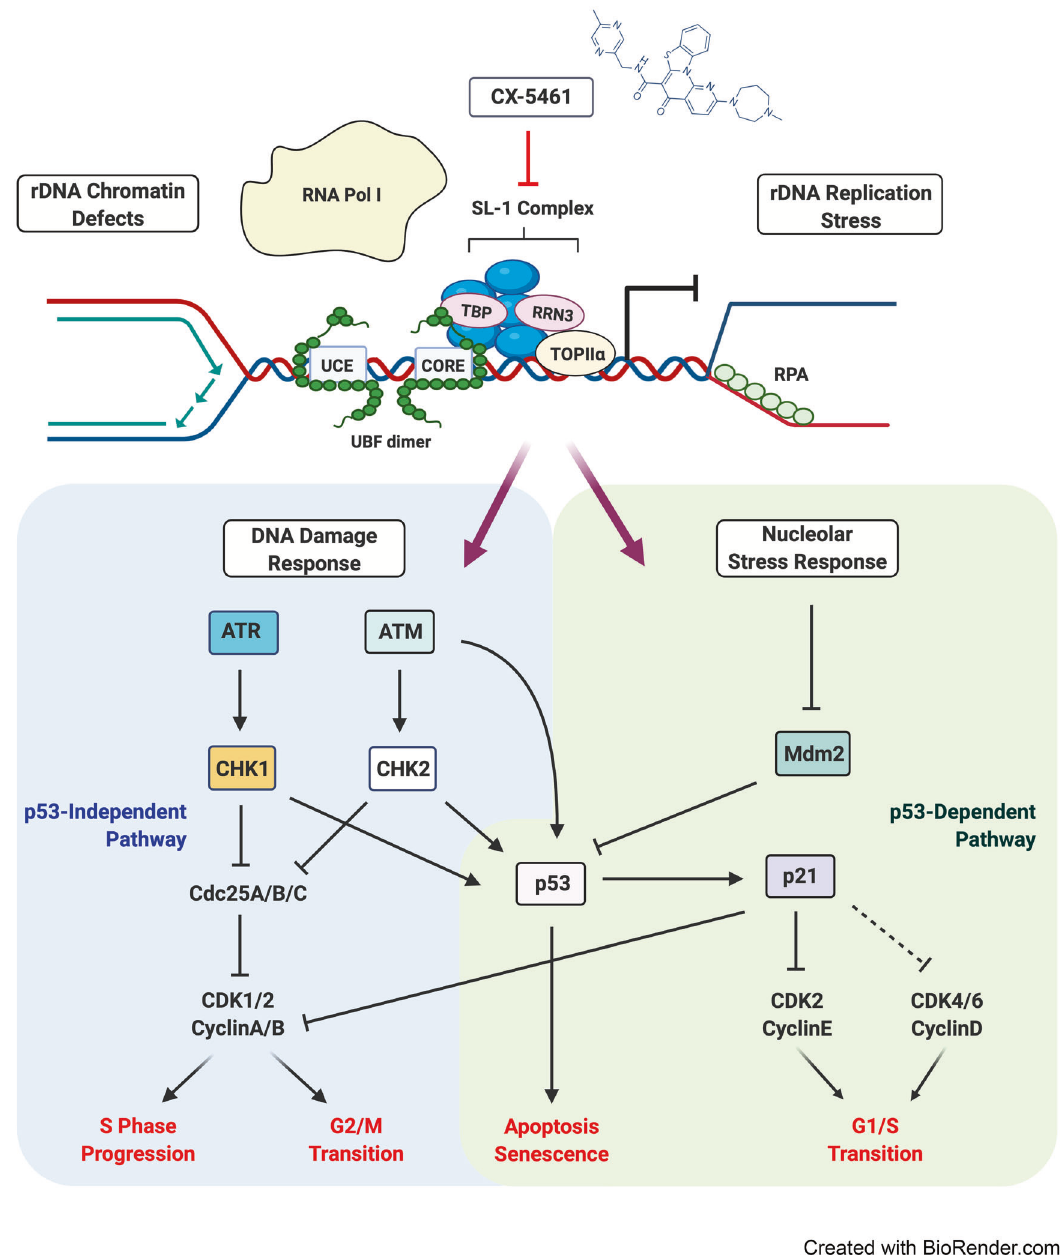
Fig. 4 Inhibition of RNA polymerase I transcription by CX-5461 induces both p53-dependent and -independent responses. A schematic representation of CX-5461 ’ s mode of action and its downstream stress response pathways. CX-5461 inhibits the initiation of Pol I-mediated transcription by disrupting the association between SL-1 and Pol I, thus preventing Pol I recruitment to the rDNA promoter. This displacement leads to “ exposed ” rDNA repeats devoid of Pol I and the presence of defects associated with an open chromatin structure and the recruitment and phosphorylation of RPA to single-stranded rDNA, a marker for replication stress. CX-5461-mediated alterations in rRNA synthesis and rDNA chromatin and topology in turn trigger the downstream activation of two major signaling pathways: ( i ) a canonical p53-dependent nucleolar stress response leading to accumulation of p53 and/or ( ii ) a p53-independent DNA damage response (DDR) involving the activation of ATM/ATR kinase signaling. Each pathway induces various cellular responses including G1/S and G2/M cell cycle defects, apoptosis and senescence. Pol I, RNA polymerase I; SL-1, selectivity factor 1; rDNA, ribosomal RNA gene; TBP, TATAbinding protein; UBF, upstream binding factor; UCE, upstream control element; RRN3, RNA polymerase I-speci fi c transcription initiation factor; Mdm2, mouse double minute 2; CHK, checkpoint kinases; CDK, cyclin-dependent kinases; ATM indicates ataxia telangiectasia mutated; ATR, ataxia telangiectasia and Rad3-related standard topotecan doses could potentially be lessened by using and stability, and increasing translational activity via stimulation of lower doses when combined with CX-5461. phosphorylation of 4E-BP1. Elevation of PIM kinase has also been CX-5461 has shown ef fi cacy in combination with other therapies found to correlate with therapeutic resistance in prostate cancer. CX- targeting ribosome biogenesis in a number of MYC-driven cancer 5461 in combination with a PIM kinase inhibitor demonstrated models. 290,293 PIM kinase is co-elevated in MYC-driven prostate marked therapeutic bene fi t compared to single-agent treatment, highlighting the promising therapeutic bene fi t in effective targeting cancer 303 and is responsible for increasing MYC transcriptional activity Signal Transduction and Targeted Therapy (2021)